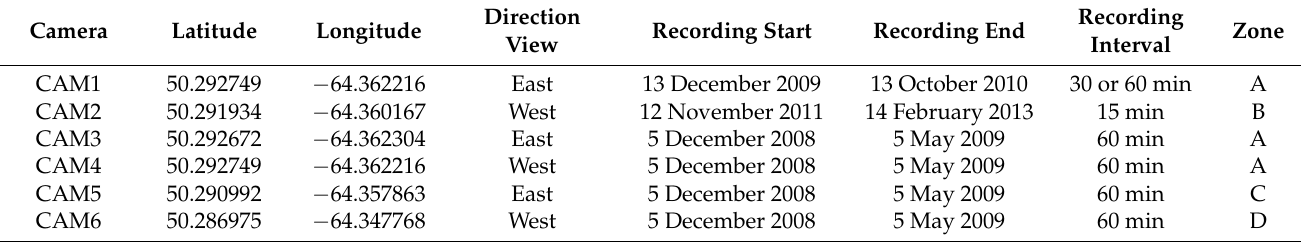
Table 1. Geographic positioning and sampling frequency of the surveillance cameras.